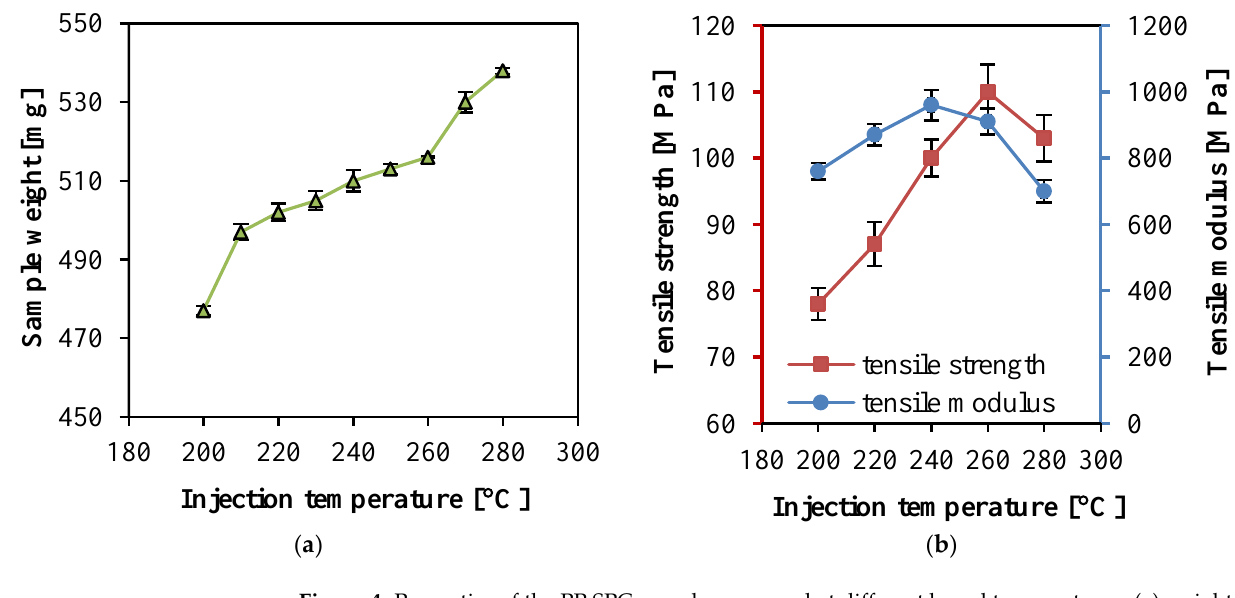
Figure 4. Properties of the PP SPC samples prepared at different barrel temperatures: ( a ) weight, and ( b ) tensile and tensile modulus.